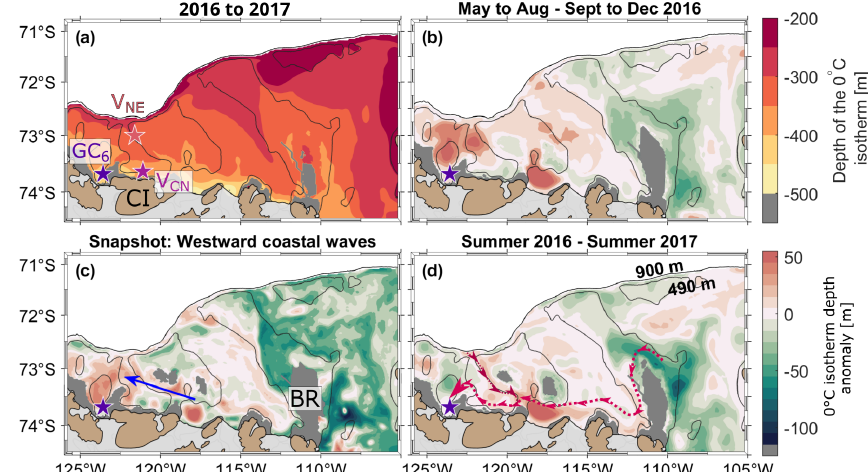
Figure 8. (a) The mean depth of the 0 ◦ C isotherm during 2016–2017. Carney Island (CI), Bear Ridge (BR), the virtual mooring locations V NE (pink star) and V CN (light purple star), and GC 6 (dark purple) are marked in colors corresponding to Fig. 7b. (b) The difference between May to August 2016 and September to December 2016. (c) A snapshot from 8 June 2016 showing an example of wave features along the northern coast of Carney Island (seasonal cycle removed and filtered with LP 8D ). The blue arrow indicates the propagation direction. (d) The difference between summer 2016 and summer 2017. The red dashed arrow indicates the suggested pathways of anomalies in isotherm depth. In all panels, the black contours indicate the 900 and 490m isobaths. The gray regions indicate that the deep 0 ◦ C isotherm is not